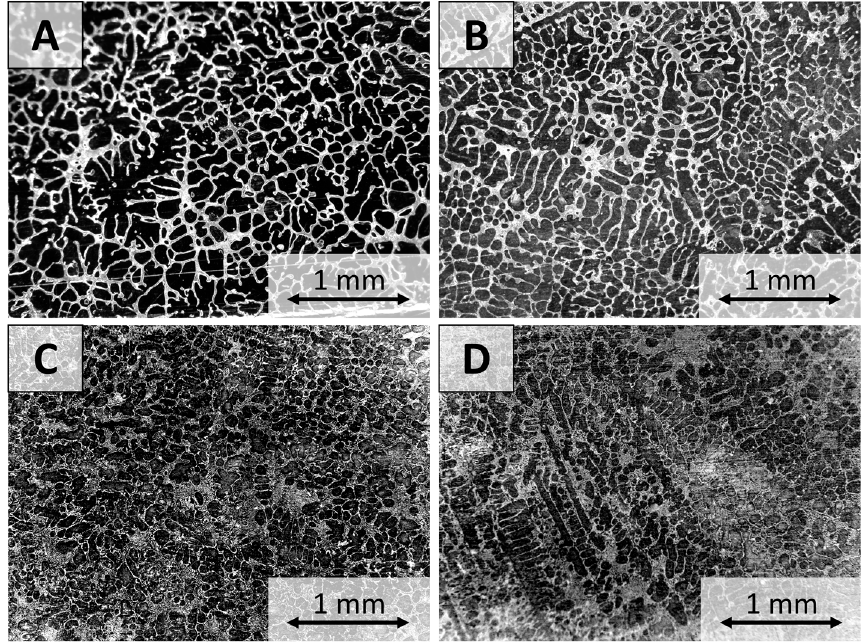
Figure 8. Microstructure of the Sn-10%wt.Pb alloy: ( A ) Reference sample; ( B ) Solidified under DC magnetic field BDC = 0.4 T; ( C ) Solidified under BDC = 0.4 T and pulses 1 Hz; ( D ) Solidified under BDC = 0.4 T and pulses 3 Hz.